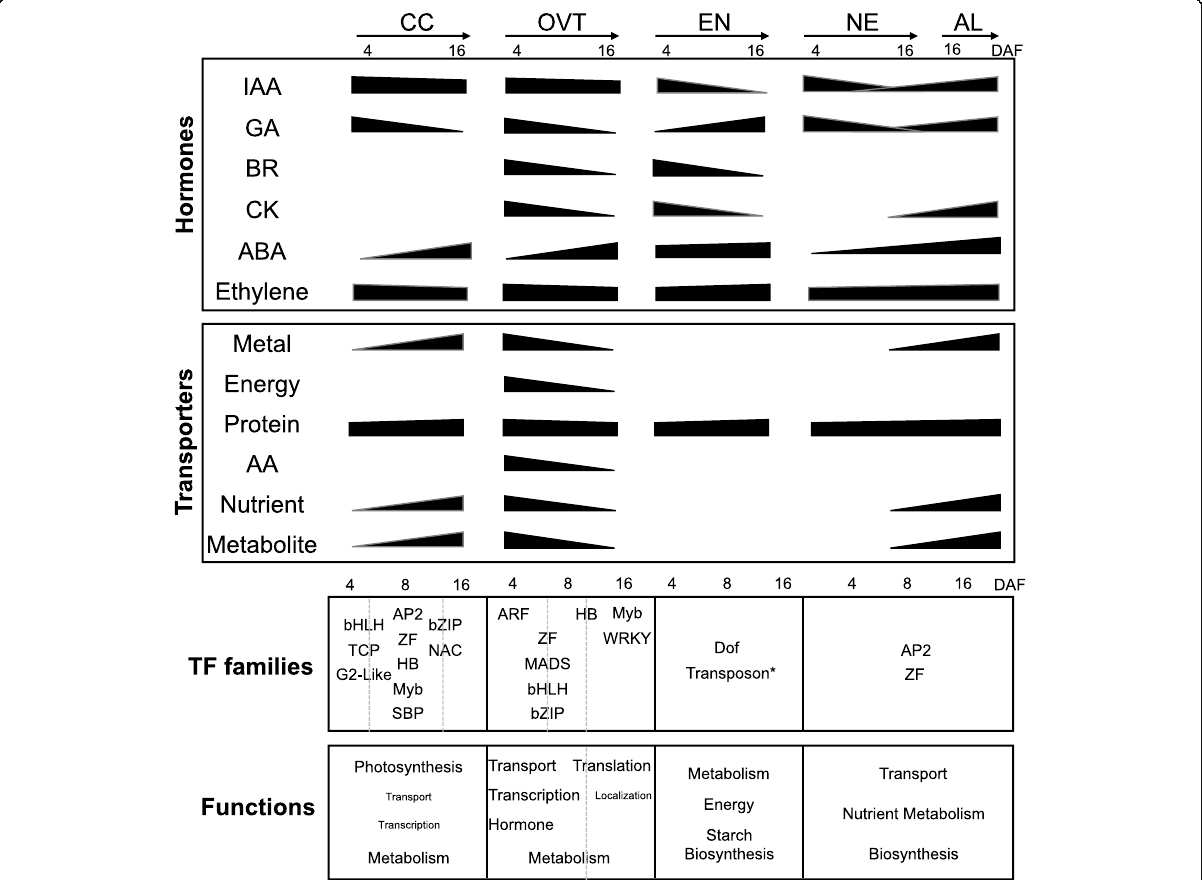
Fig. 8 Summary of spatio-temporal gene expression regulation in different tissues during rice grain development. Upper panel: Changes in the expression of hormone-regulated genes and genes encoding transporters in CC, OVT, EN, NE and AL are summarized. Enriched TF families in different sub-regions during different developmental stages are indicated. The sloped bars indicate the activity of hormone or transporter genes in the respective stage and tissues. Lower panels: DEGs of TFs enriched in the five tissues at different stages of grain development (4, 8 and 16 DAF; separated by dashed lines). TFs that were enriched in more than one stage are shown across two columns. The enriched metabolic, physiological and cellular functions in each tissue are each stage are shown. Functions that were enriched at more than one stage are shown across the column. The different font size of the terms indicate their degree of